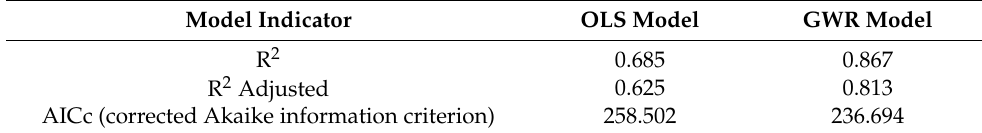
Table 3. Indicators of different